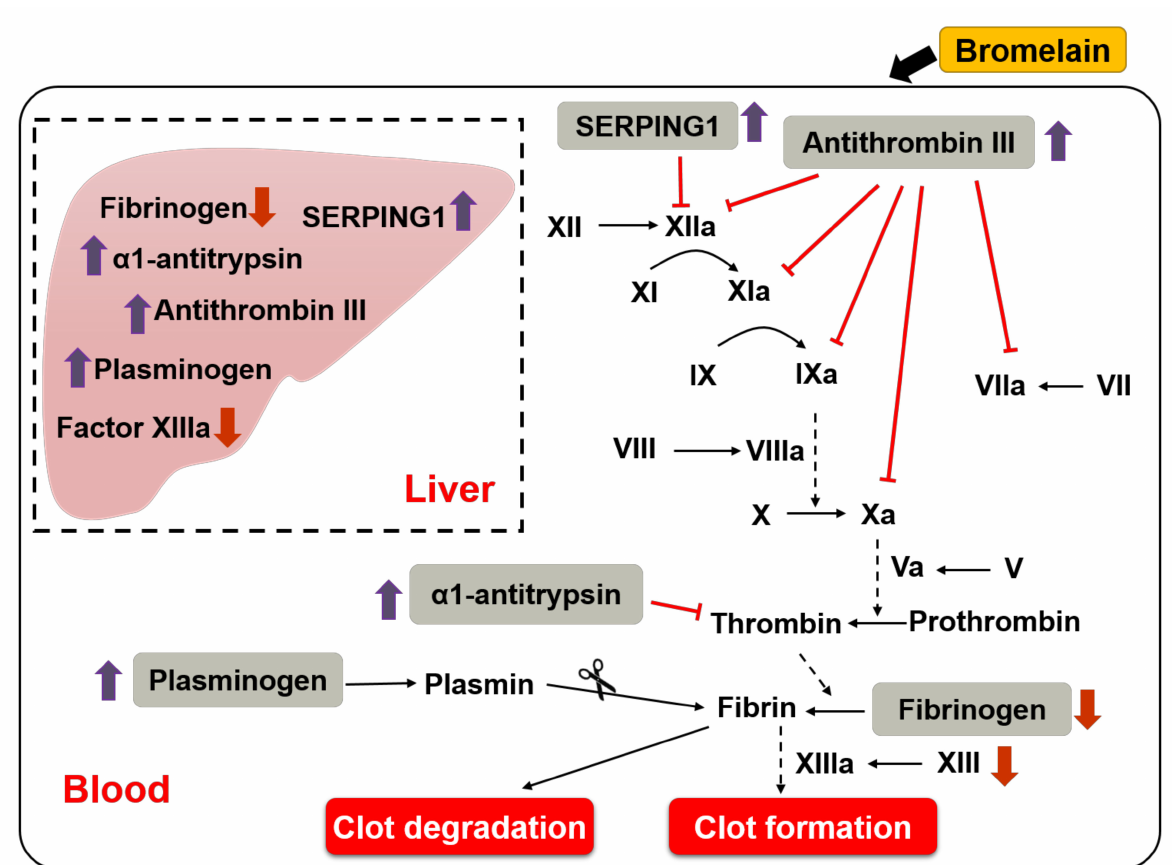
Figure 5. Schematic illustration of the molecular mechanism through which bromelain induces anticoagulant effects in HFD − fed mice. As shown, daily administration of BL for 12 weeks increased the expression of ATIII, SERPING1, α 1-antitrypsin, plasminogen, and decreased the expression of FIB and factor XIII in the liver and plasma of HFD-fed mice, leading to inhibition of the intrinsic, extrinsic, and common pathways and activation of fibrinolytic pathway. These events may work in concert to inhibit NAFLD-induced thrombus formation. Abbreviations: SERPING1, serpin family G member 1. Red and purple arrows mean upregulation and